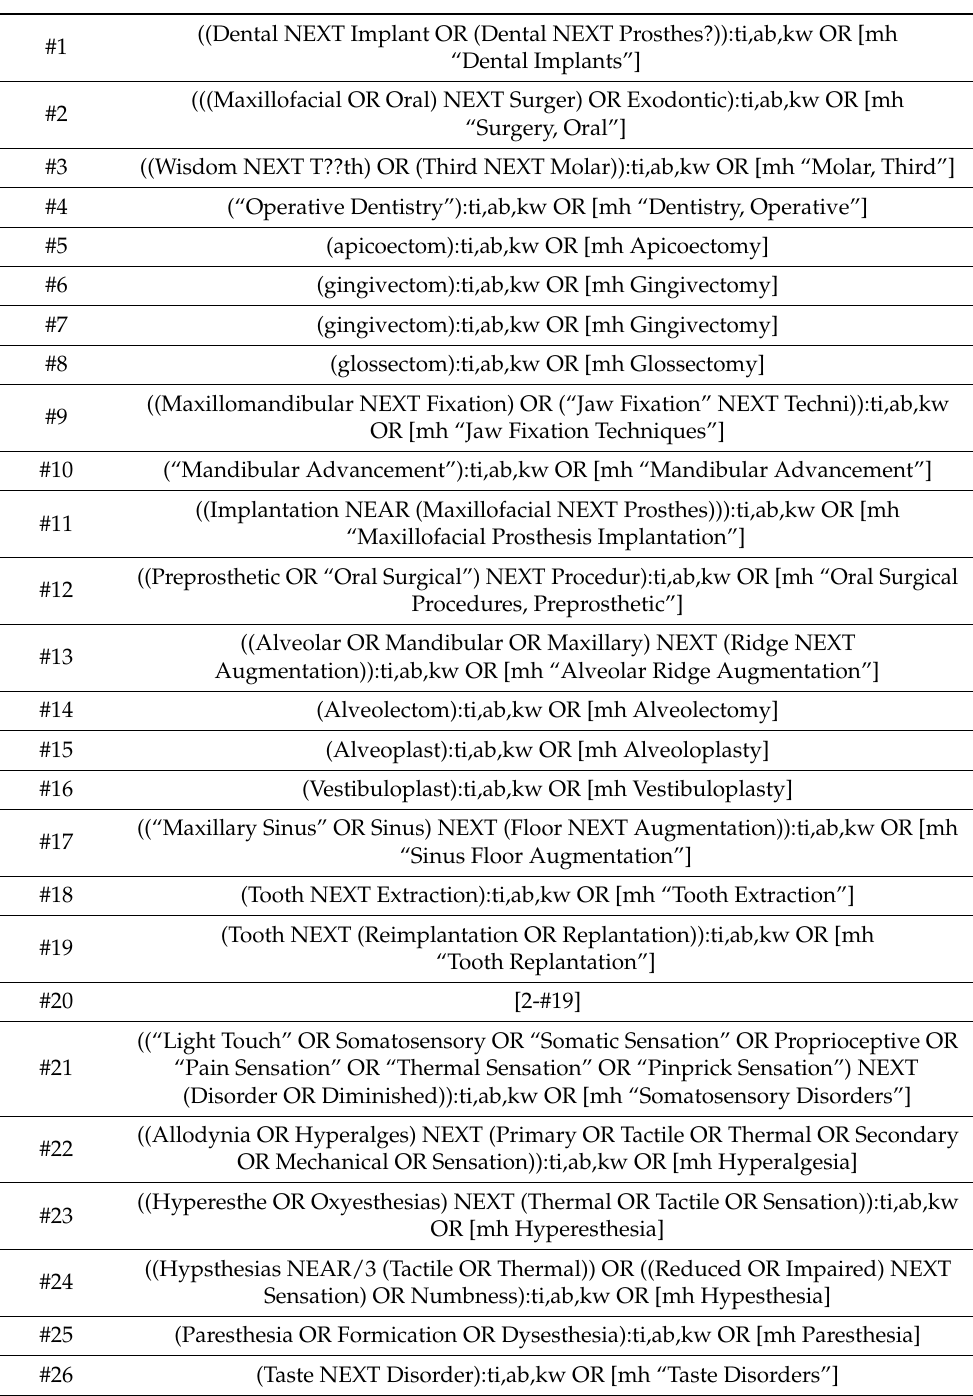
Table 3. Detailed search strategy in